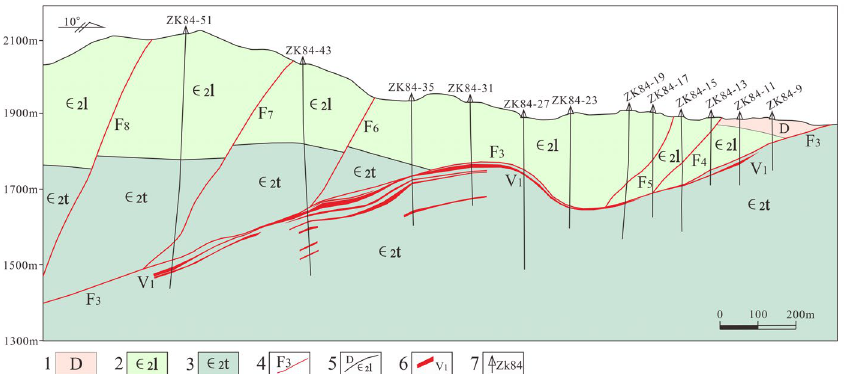
Figure 2. Cross-section along exploration line 66 (Figure 1c): 1. Devonian strata; 2. Middle Cambrian Longha Formation; 3. Middle Cambrian Tianpeng Formation; 4. Fault; 5. Geological boundary; 6. Ore body; and 7. drill hole.